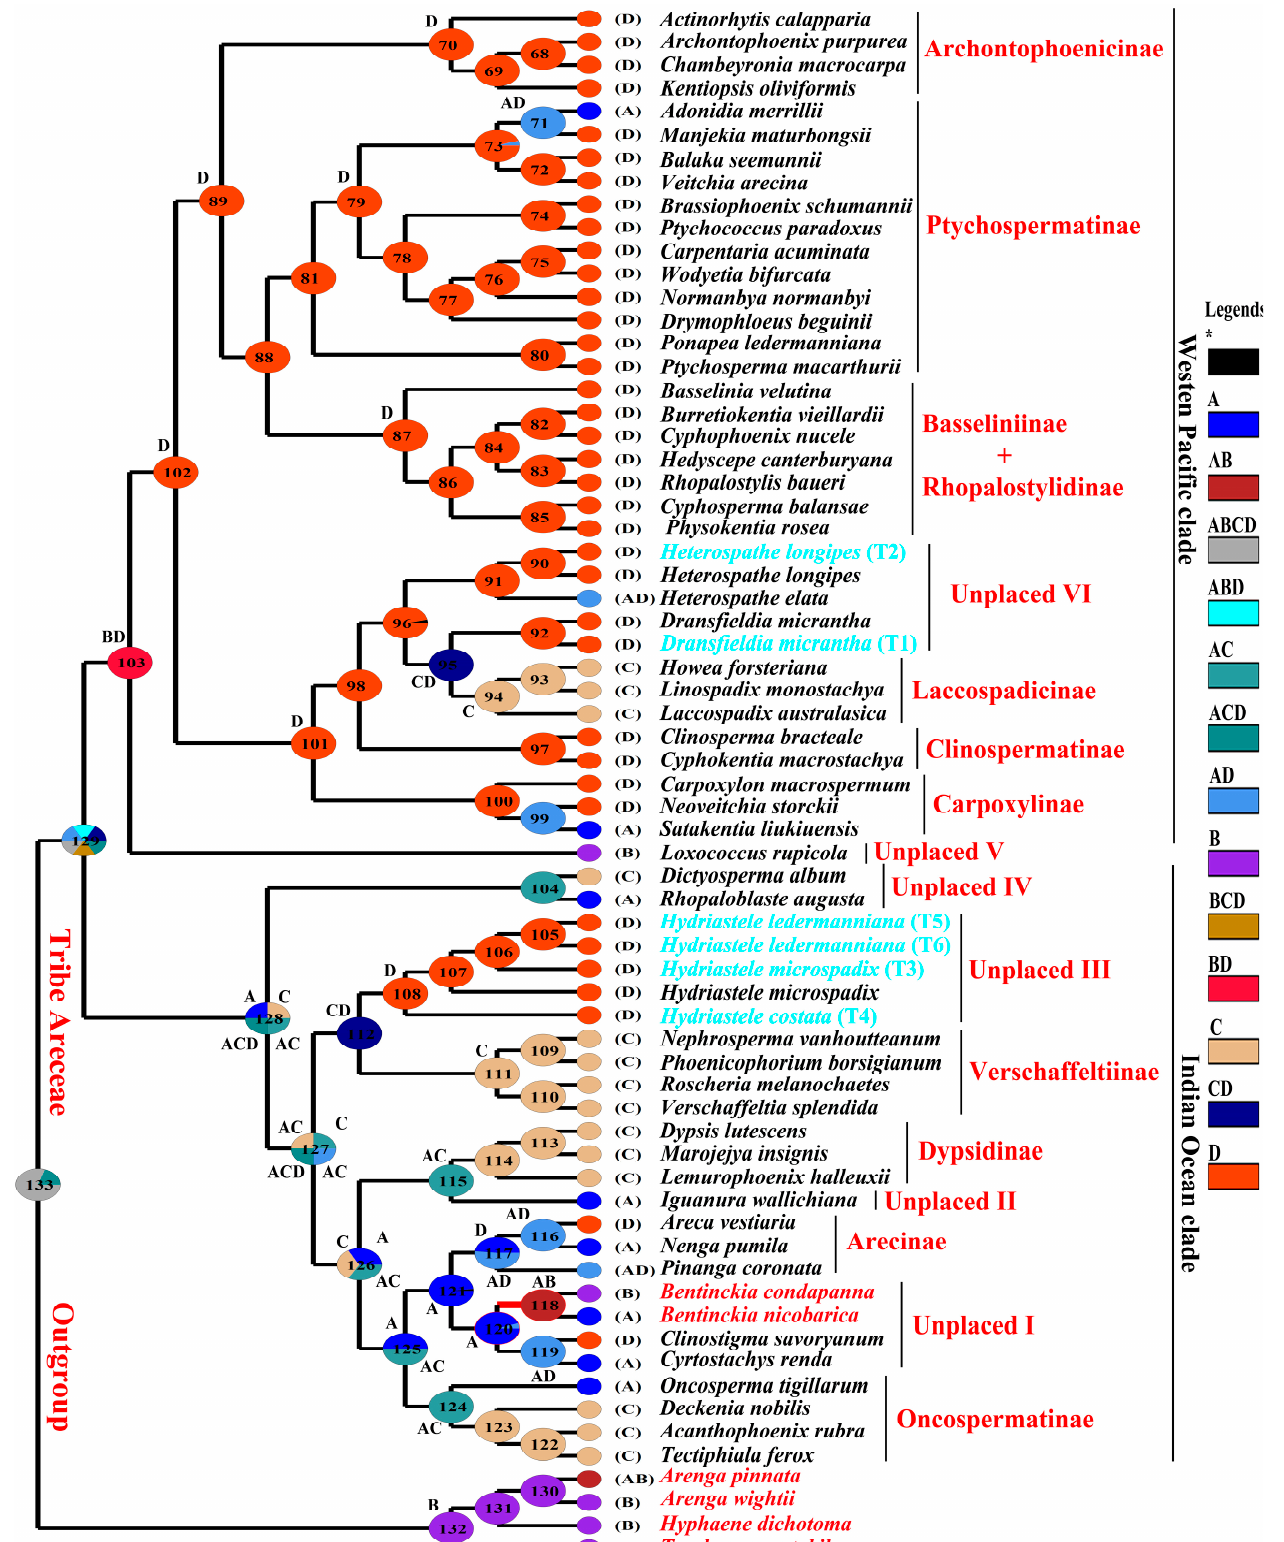
Figure 6. Biogeographic analysis of Areceae based on the Bayesian all compatible groups tree. * (Black colour), ranges with probabilities < 5% are hidden and lumped together and reported as *.